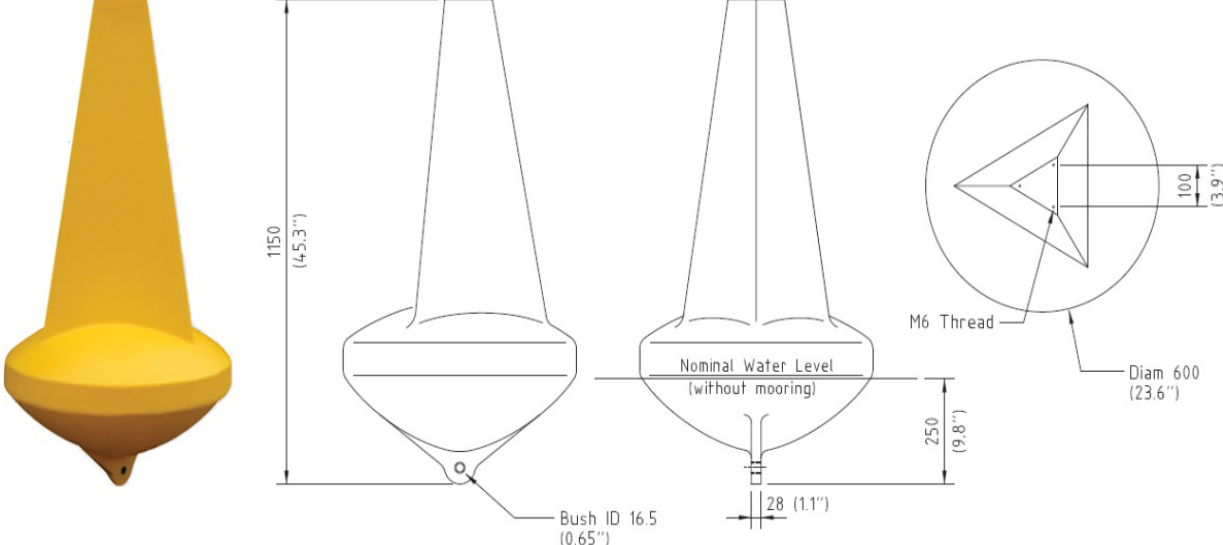
Figure 20. The Sealite ® SLB600 buoy used for the SEMAT Mk3